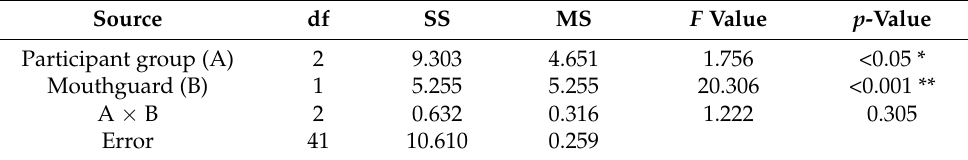
Table 3. Results of COP-Area displacement by a split-plot design analysis.